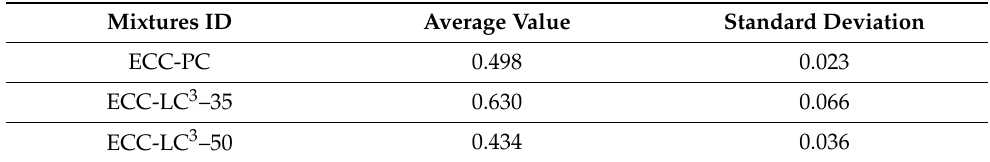
Table 9. Frictional bond strength τ 0 . (Unit: MPa).